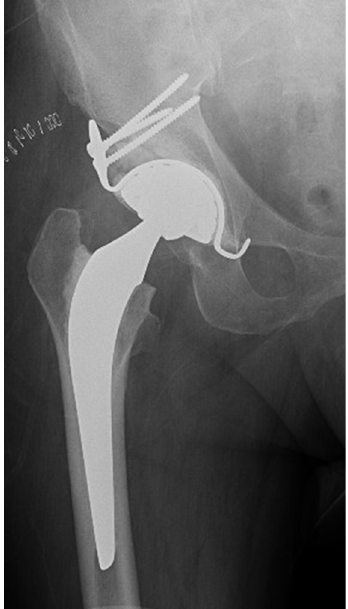
Figure 13. Post-operative